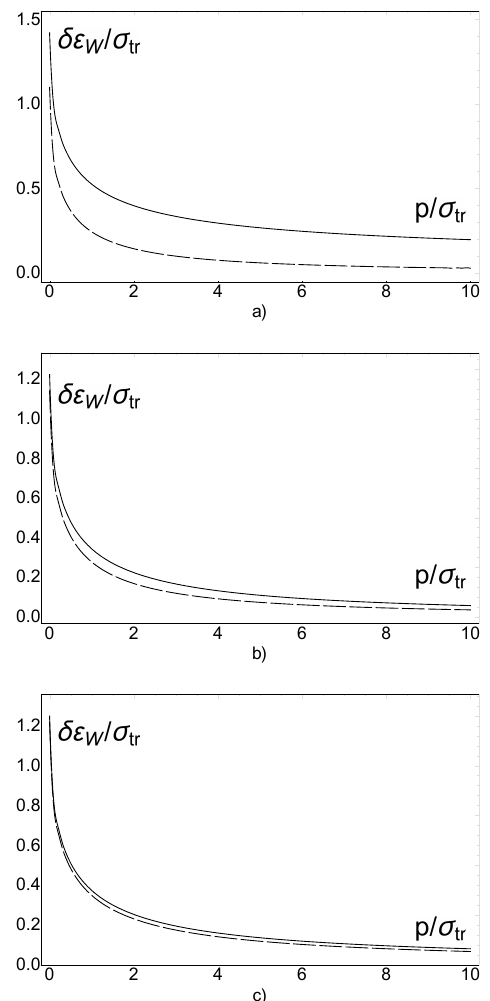
Figure 8. Comparison of δε W and δε Wgeom (solid and dashed lines, respectively). The cases are the same as in Figure